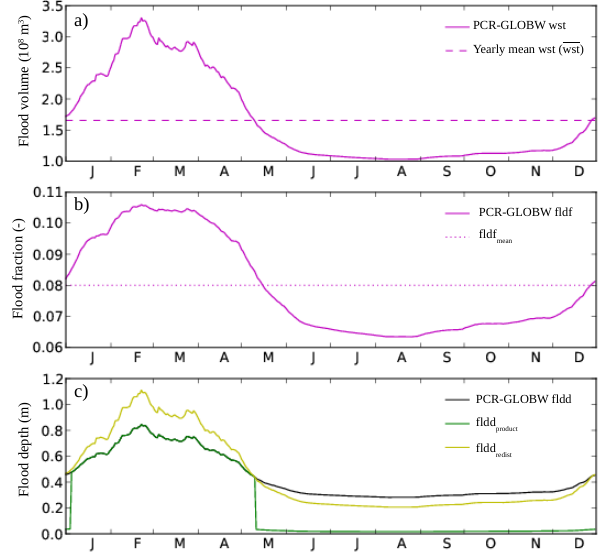
Fig. A1. On a given grid cell, outputs of PCR-GLOBWB and corre- sponding inputs to LPX: (a) Water storage: seasonal cycle simulated by PCR-GLOBWB (solid) and mean annual value (dashed); (b) floodplain fraction: seasonal cycle simulated by PCR-GLOBWB (solid) and yearly constant value derived from mean annual water storage (dotted; called fldf mean ); (c) flood depth: output of PCR- GLOBWB (black, fldd) over a seasonal-variable floodplain frac- tion and flood depths (fldd product and fldd redist ) computed over the yearly constant floodplain fraction (fldf mean ). Both fldd redistt and fldd poduct are used as input of LPX. See Eq. (1) and 2 for computa- tion of fldd redist and fldd product .